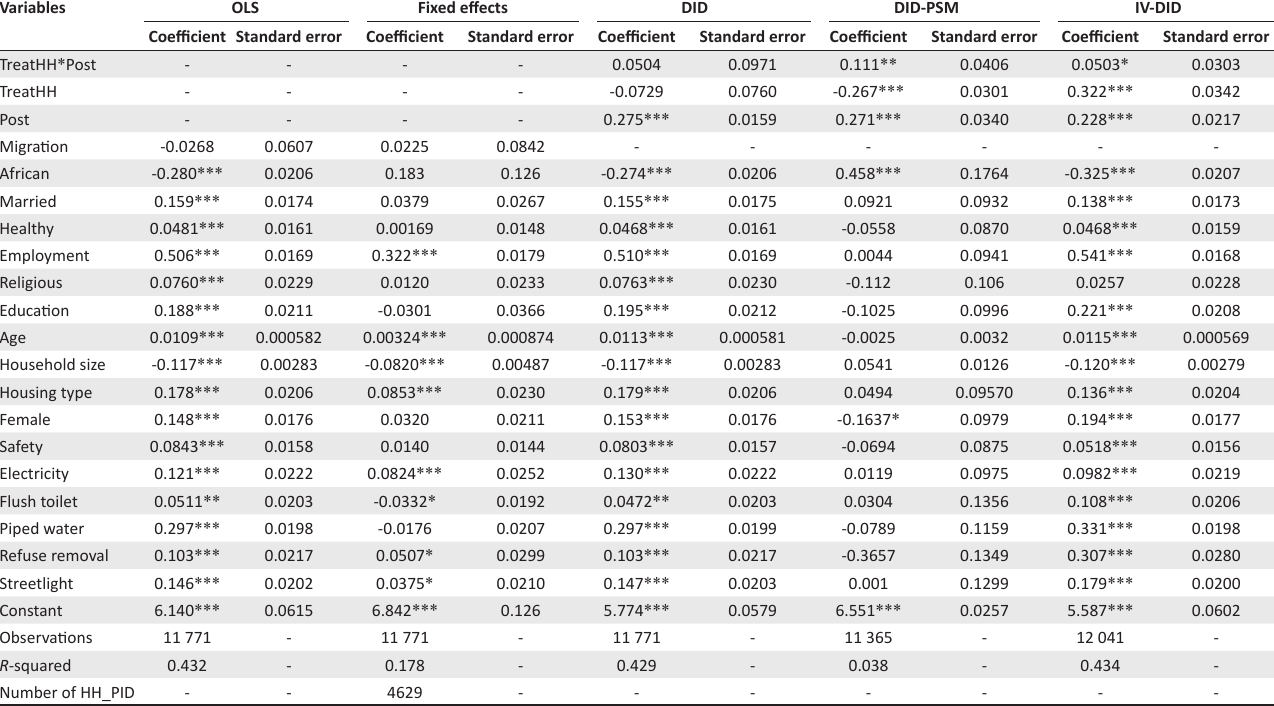
TABLE 6: Impact of migration on the sending household income per capita (log). Variables OLS Fixed